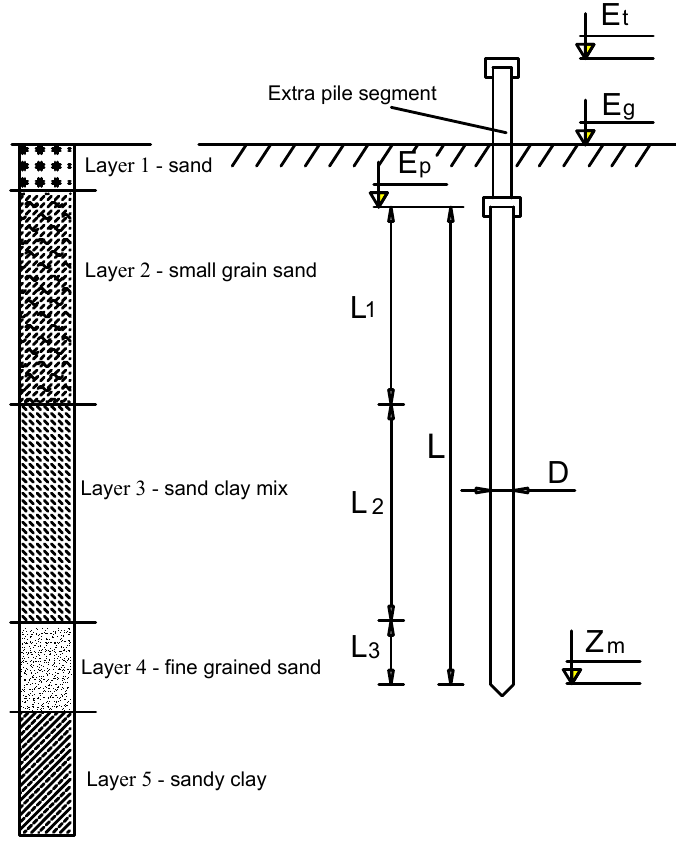
Figure 2. Schematic diagram for soil stratigraphy and pile parameters. Table 1. Inputs and output of the present study